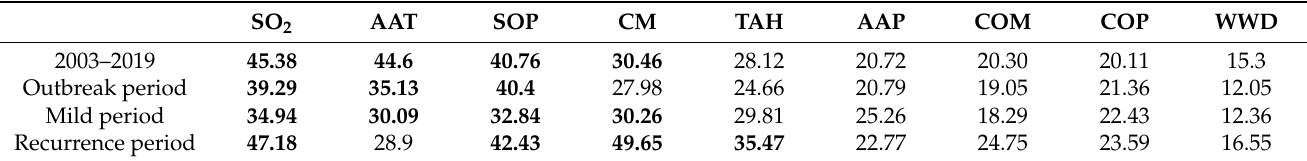
Table 4. The explanatory power of the influencing factors on spatial heterogeneity of Brucellosis (%). SO 2